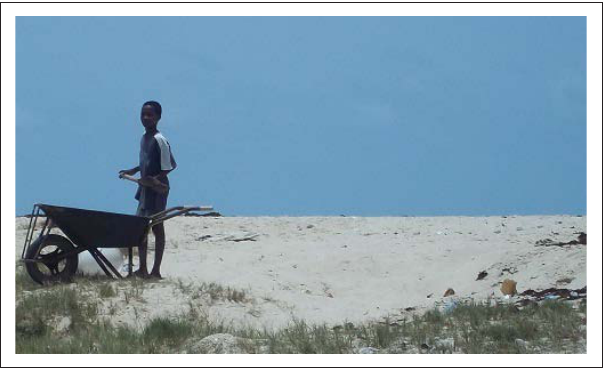
FIGURE 9: Excessive sand mining at Glefe beach is contributing to severe